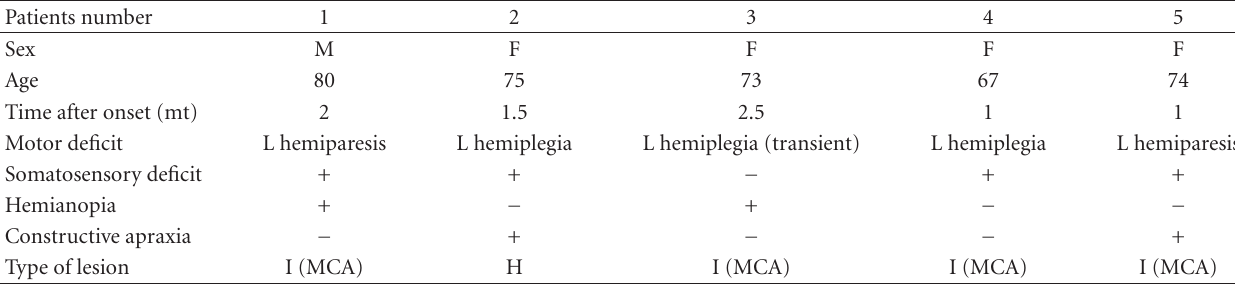
Table 1: Clinical profiles of each